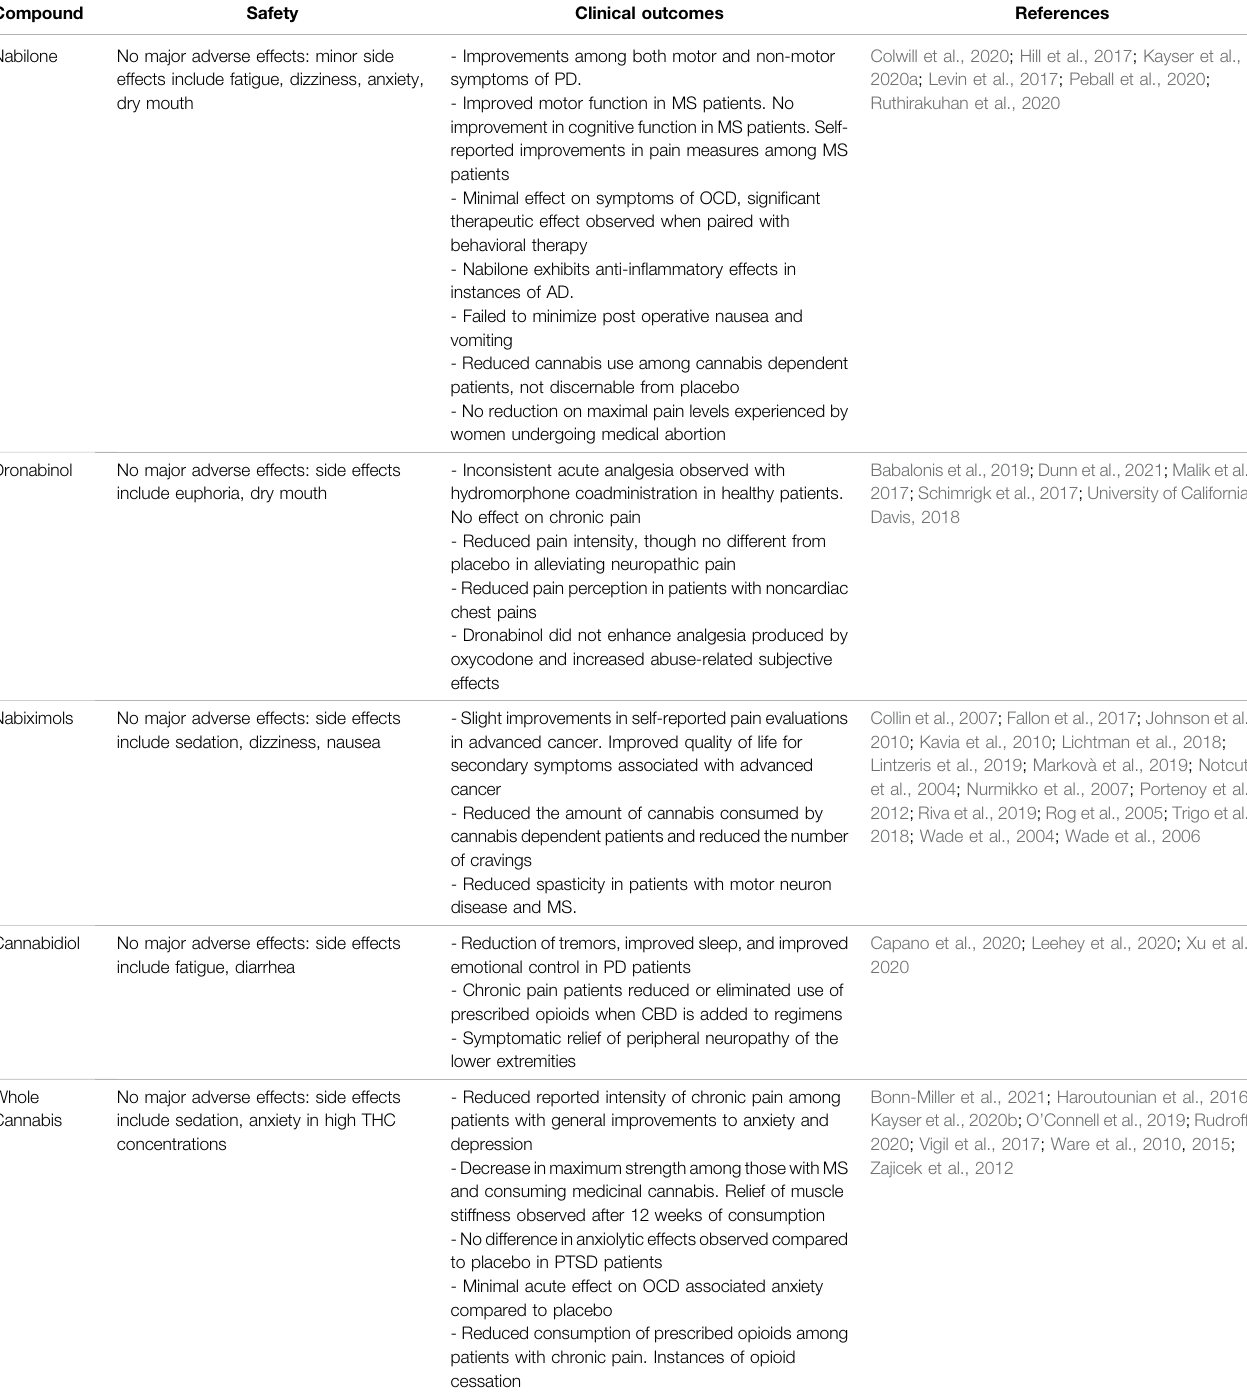
TABLE 1 | Cannabinoids and the clinical work done investigating them as novel